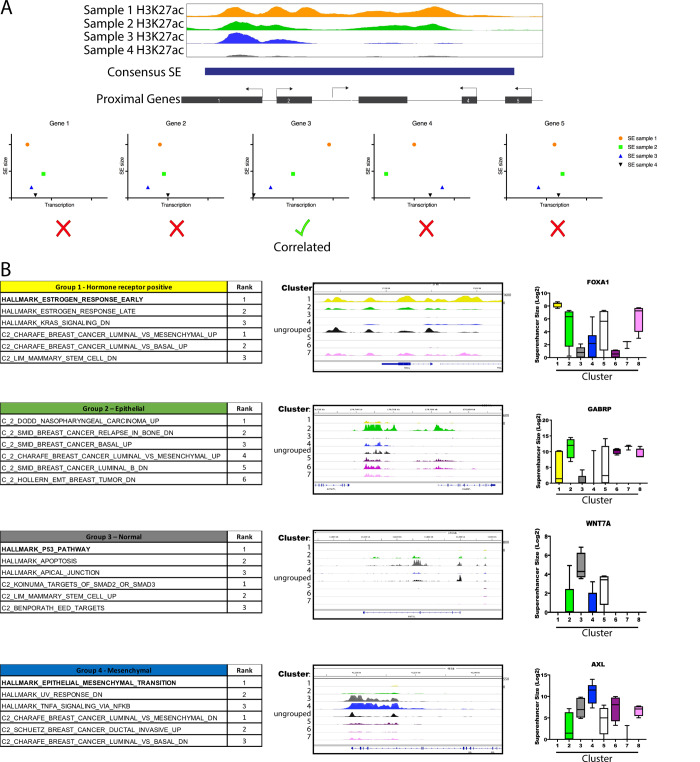
TNBC SE profiles define unique tumor subsets.A) Cartoon depiction of a fictional SE with overlapping and adjacent genes. Scatter plots show fictional example gene expression RPKMs vs. SE sizes, B) Gene Set Enrichment Analysis (GSEA) results for each subgroup. Left panel shows GSEA results for putative target genes from each Cluster-specific set of enhancers. Right panel shows example H3K27ac ChIP-Seq tracks and boxplots for superenhancers from each Cluster. Each track shown is an overlay of the tracks for all samples present in each group. Boxplots for each track example shows the total distribution of SE sizes for the samples in each Cluster. Mean, and interquartile range are shown; whiskers represent the minimum and maximum group values.